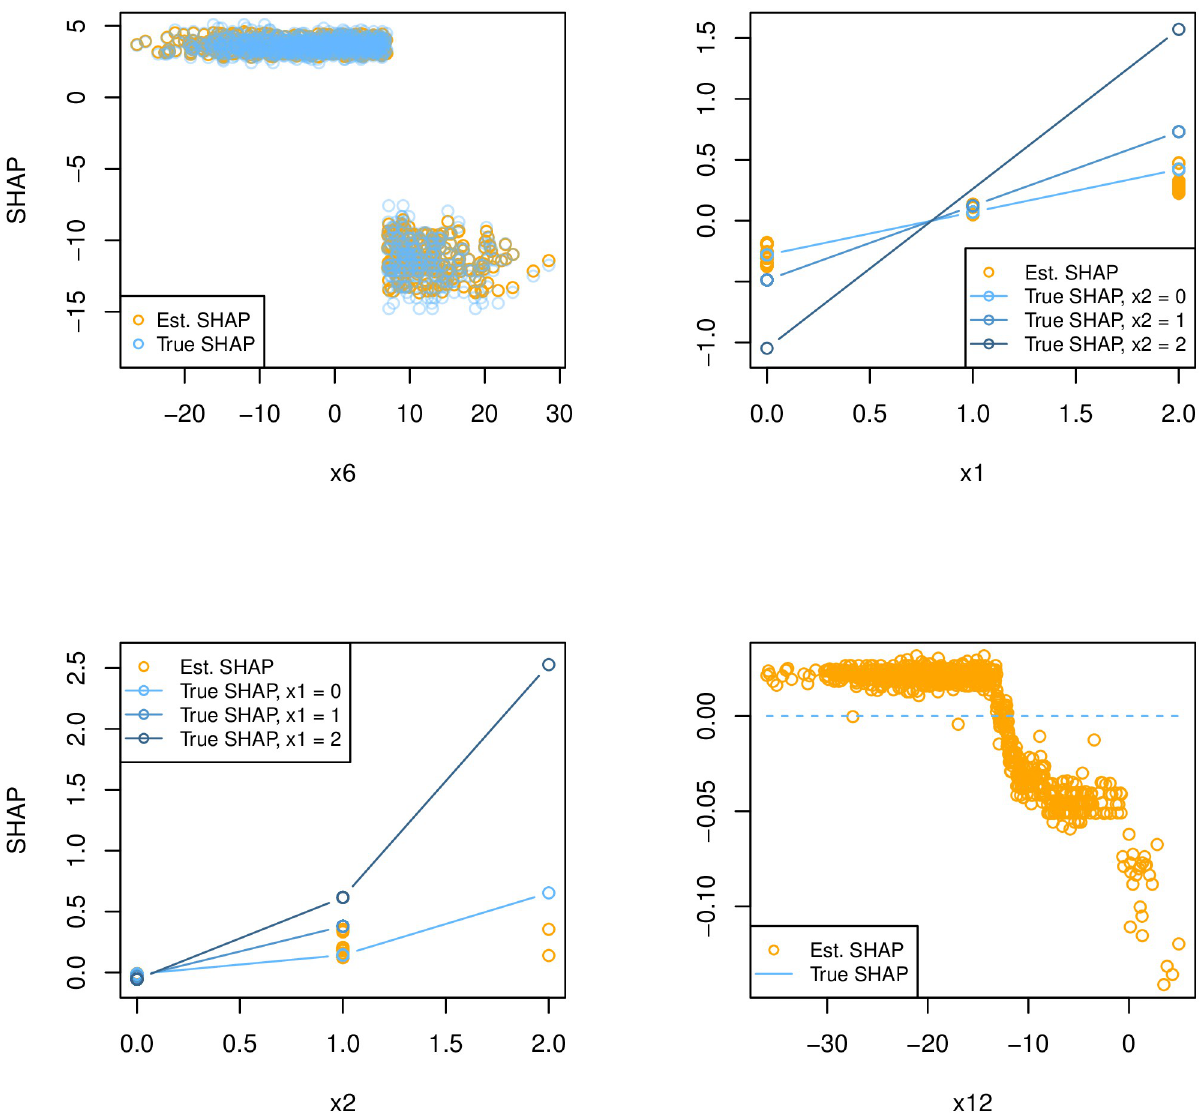
Fig 3. Comparison of true SHAP value for each data point with the estimated SHAP value from the model fitted on the synthetic data, Eq (19). The deviations explain the reasons behind under- and overestimation of feature importance using SHAP values.